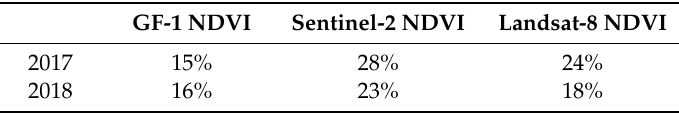
Table 5. Percentage statistics of NDVI threshold greater than